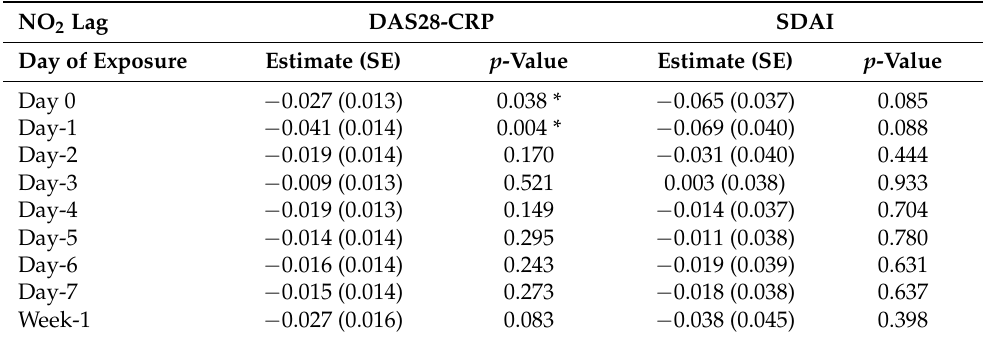
Table 4. Associations between NO 2 short-term exposure and RA disease